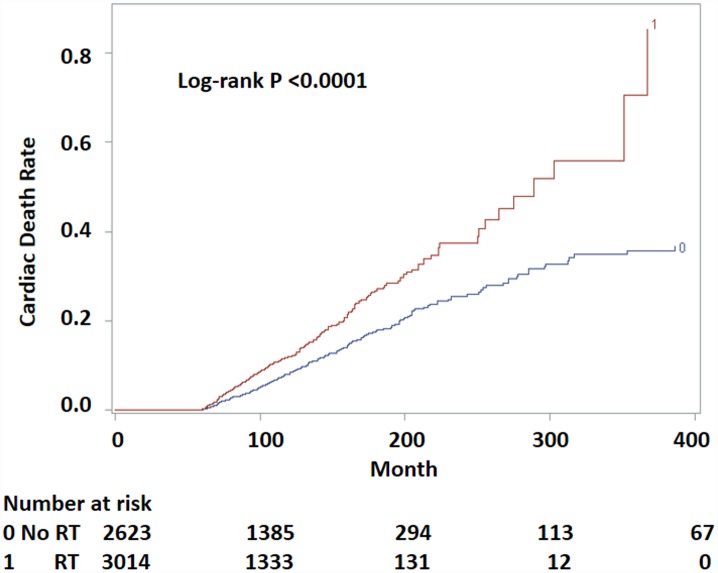
Probability of cardiac death by RT status for long-term survivors of esophageal cancer.Numbers at risk indicate patients liable to be censored or undergo failure at each time period.